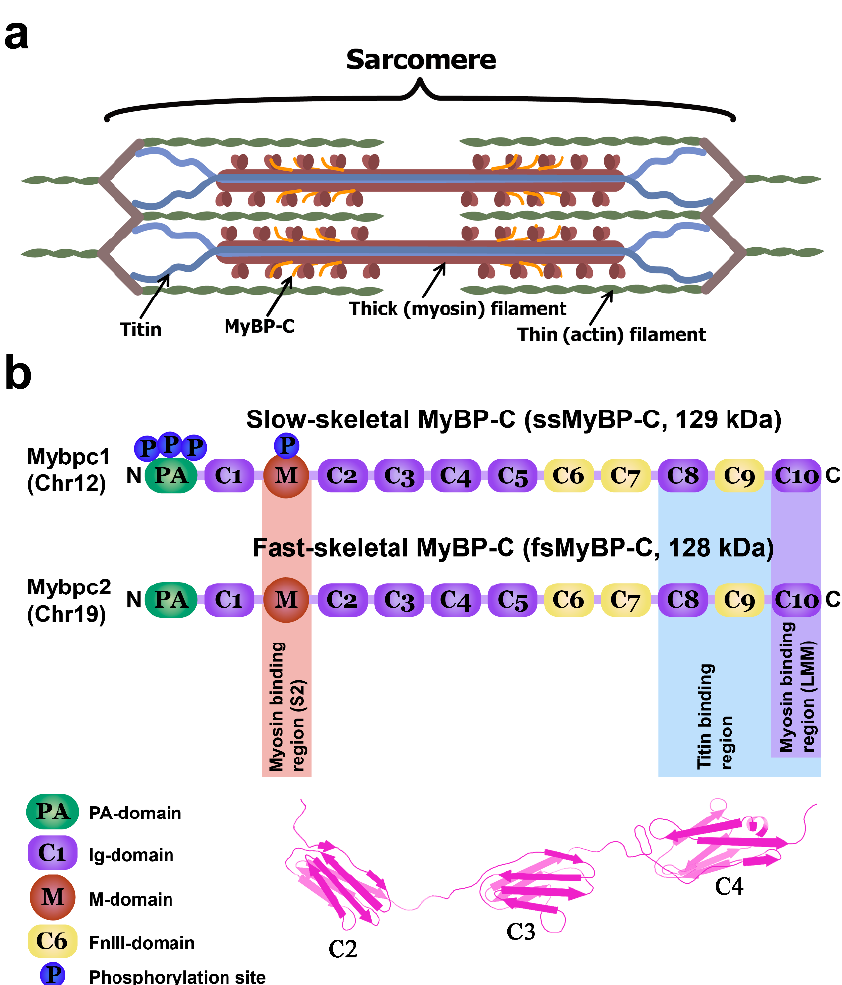
Figure 1. MyBP-C structure and location in the sarcomere. ( a ) Schematic structure of muscle sarcomere with thick and thin filaments. MyBP-C is localized in the C-zone and is shown in orange. ( b ) Domain structure of two paralogs of MyBP-C (based on schemes in [12,13]). Below, a schematic structure of three Ig-like ssMyBP-C domains (C2–C4). ssMyBP-C has three phosphorylation sites in the proline-alanine domain (PA-domain) and one within the M-domain. The region responsible for binding to titin (highlighted in blue) includes domains C8–C10. Interaction of domains C8–C10 with titin is shown for cardiac MyBP-C only [21–23]. Schematic diagram of structure C2–C3–C4 domains was drawn based on the PDB file https://www.uniprot.org/uniprot/Q00872.